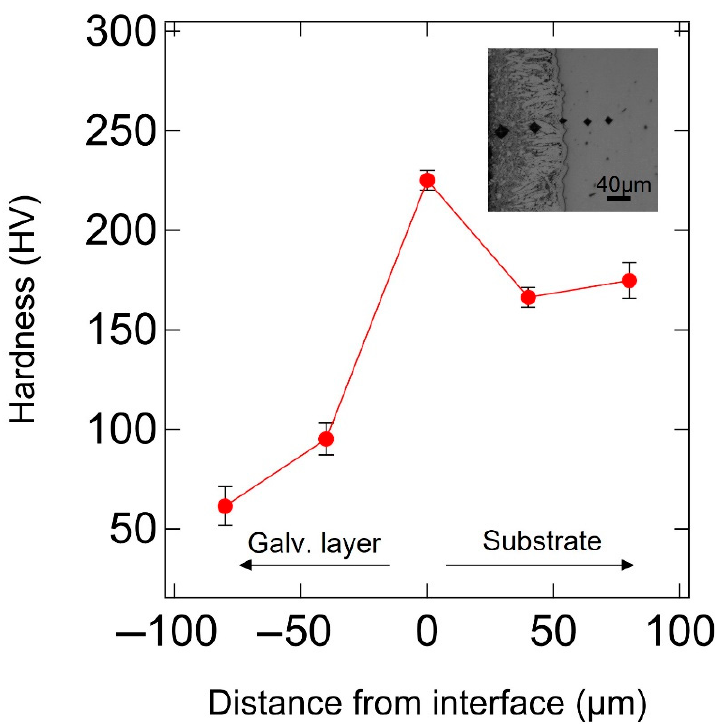
Figure 5. Vickers micro-hardness measurements across the plating layer and substrate interface from the outermost eta phase to the substrate.